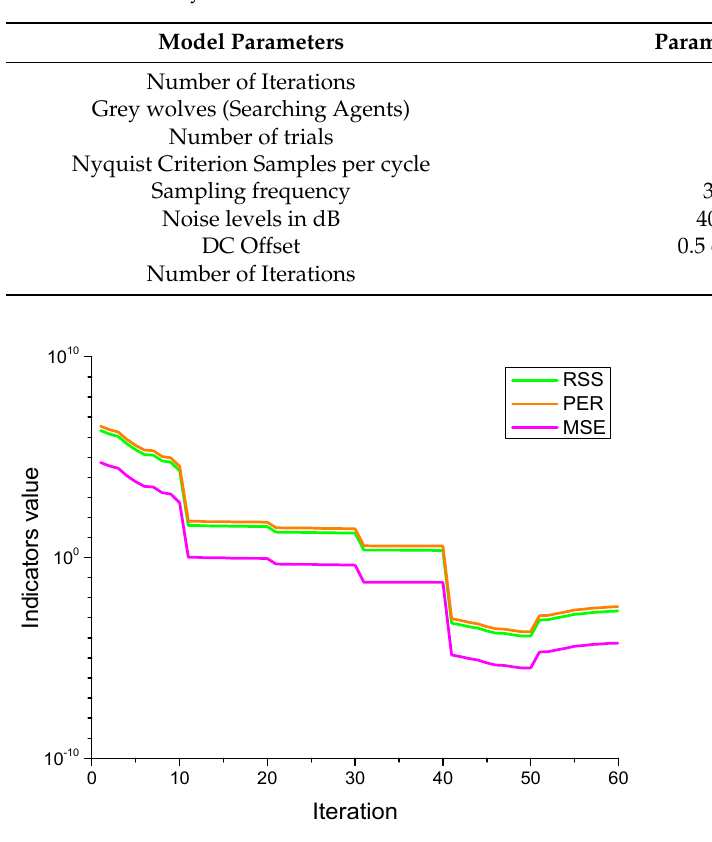
Table 4. Case Study I Parameters after Simulation.